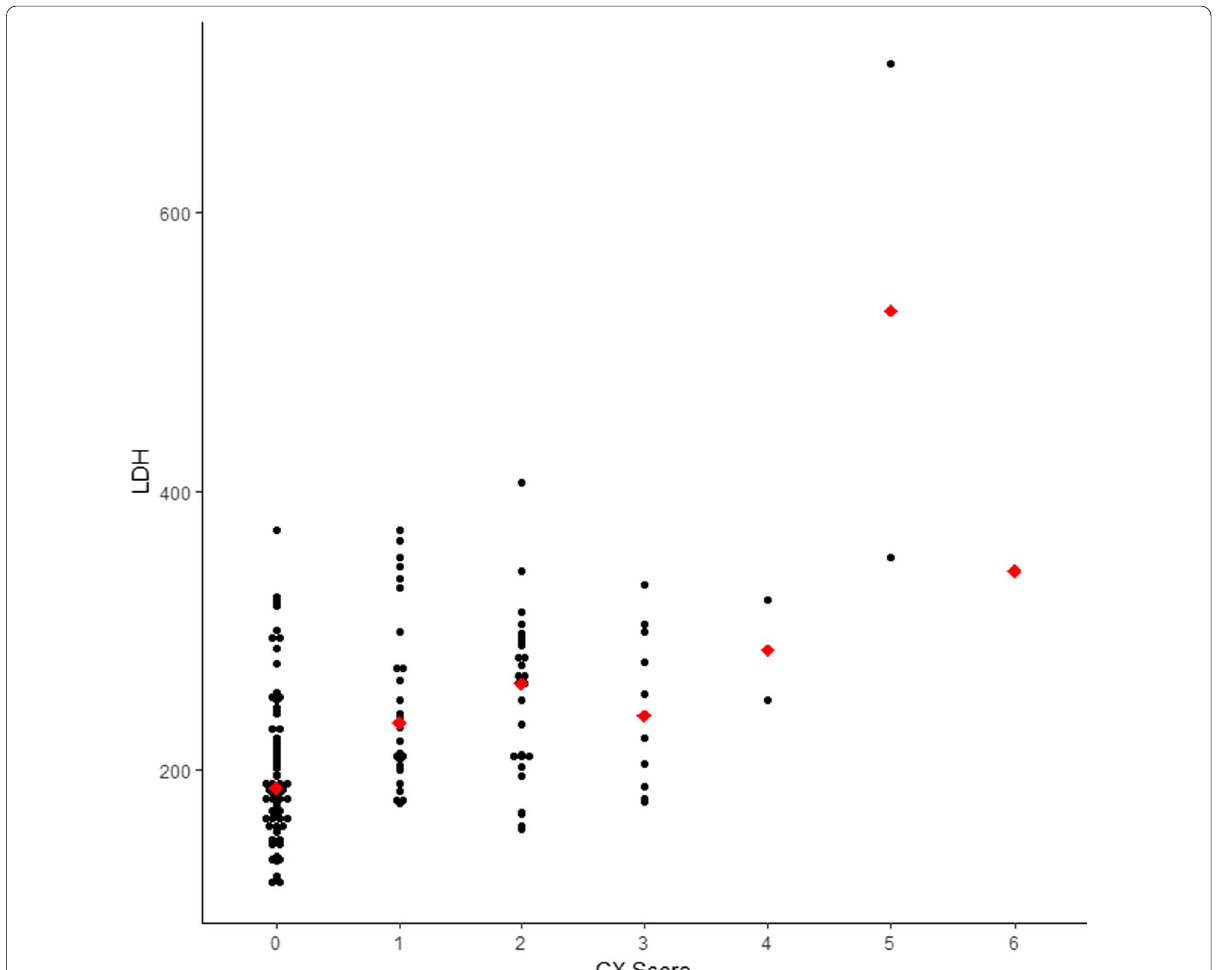
Fig. 4 Dot plot of LDH by chest radiographic score. The red-colored diamond shaped observations in the dot plot represent the median of LDH in each chest radiographic score (CX